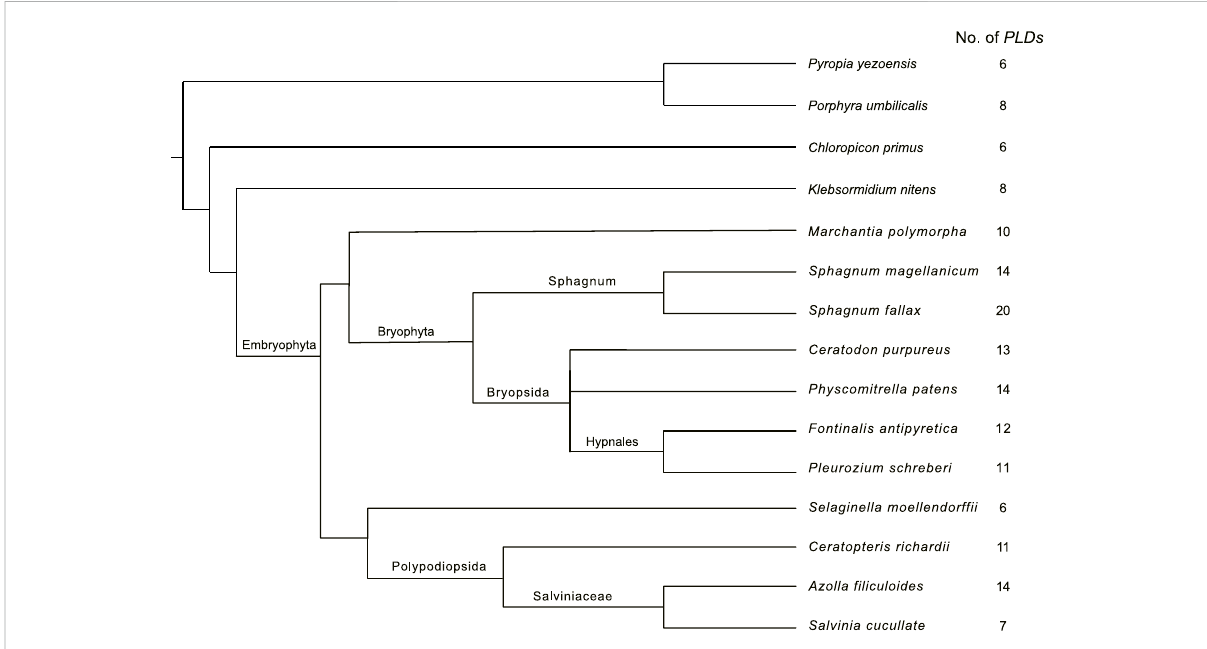
FIGURE 1 Species tree of the studied mosses, clubmosses, ferns, liverworts, and algae. This tree was drawn according to Harris et al. (2020). The column on the right indicates the number of PLD